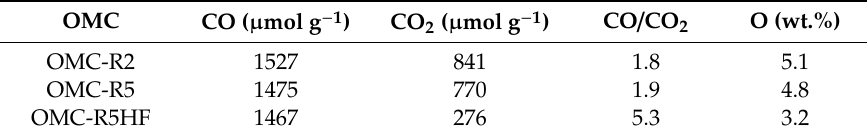
Table 2. Surface chemistry of OMC supports.